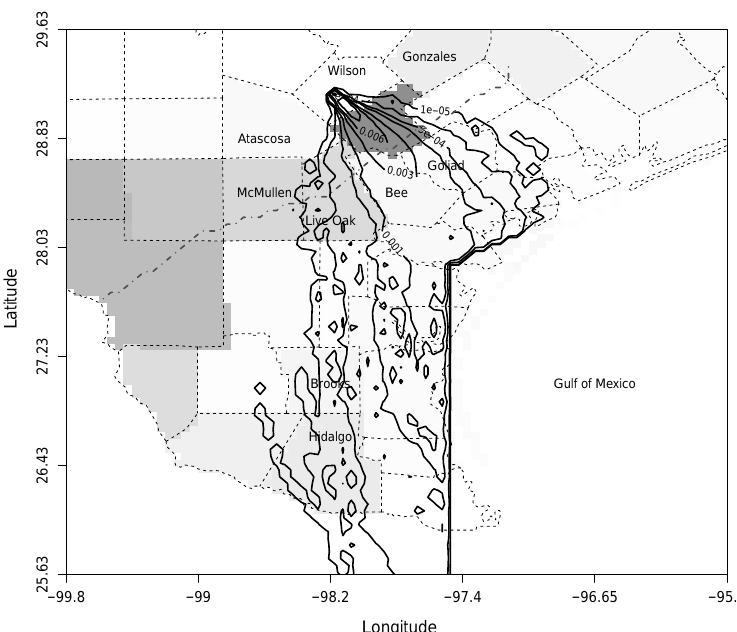
Figure 4. An example of an integral backward dispersion plume map created from 5000 particles released above the Floresville receptor site and followed backwards in time (20h) into the model lowest vertical level ( < 50ma.g.l.) to assess surface emitter impacts. The raw map was normalized to its total after removing all surface impacts over the Gulf of Mexico. The grey shading underlying the plume map identifies counties with the sum of natural gas and associated gas production, with darker shading indicating higher production rates. The darkest shading indicates Karnes County, not labeled for clarity. Many counties, including Wilson County where Floresville is located, are lightly shaded due to the relatively low production of natural gas. The dark grey jagged line extending from the west-southwest near the Mexican border to the east-northeast south of Gonzales County marks the southern “edge” of the